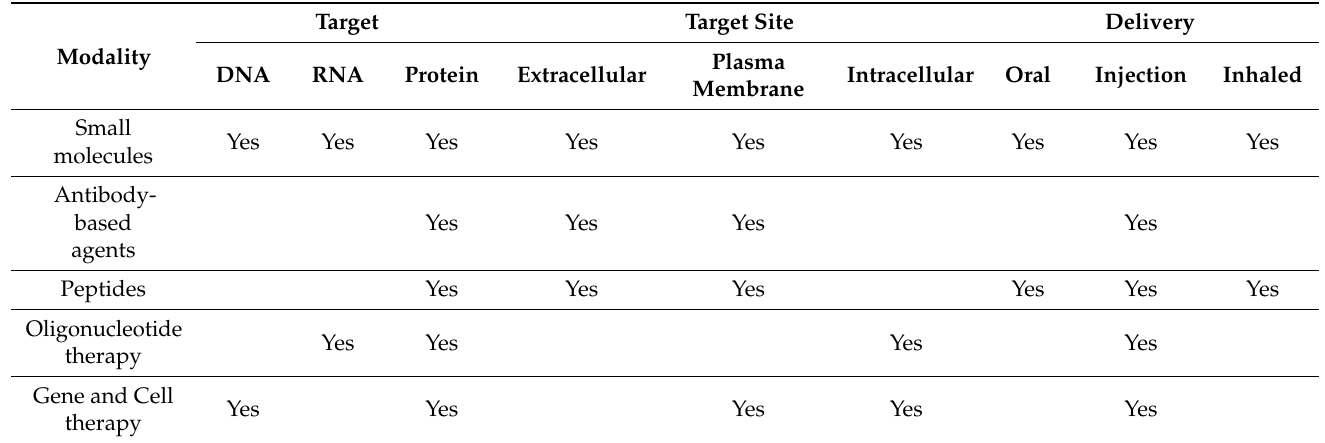
Table 2. Overview of approved therapeutic